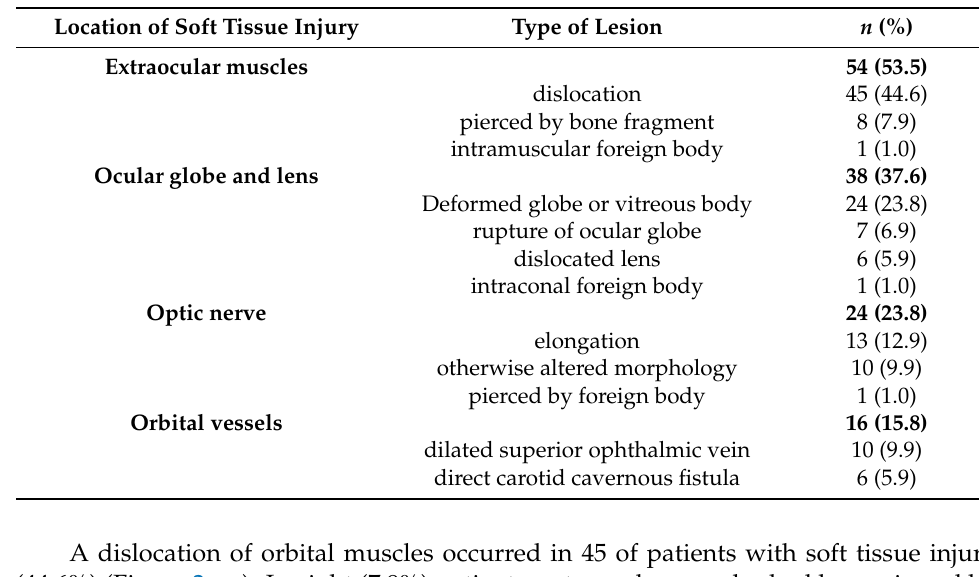
Table 4. Types and frequency of orbital soft tissue injuries showed a dominance of extraocular muscle injuries.